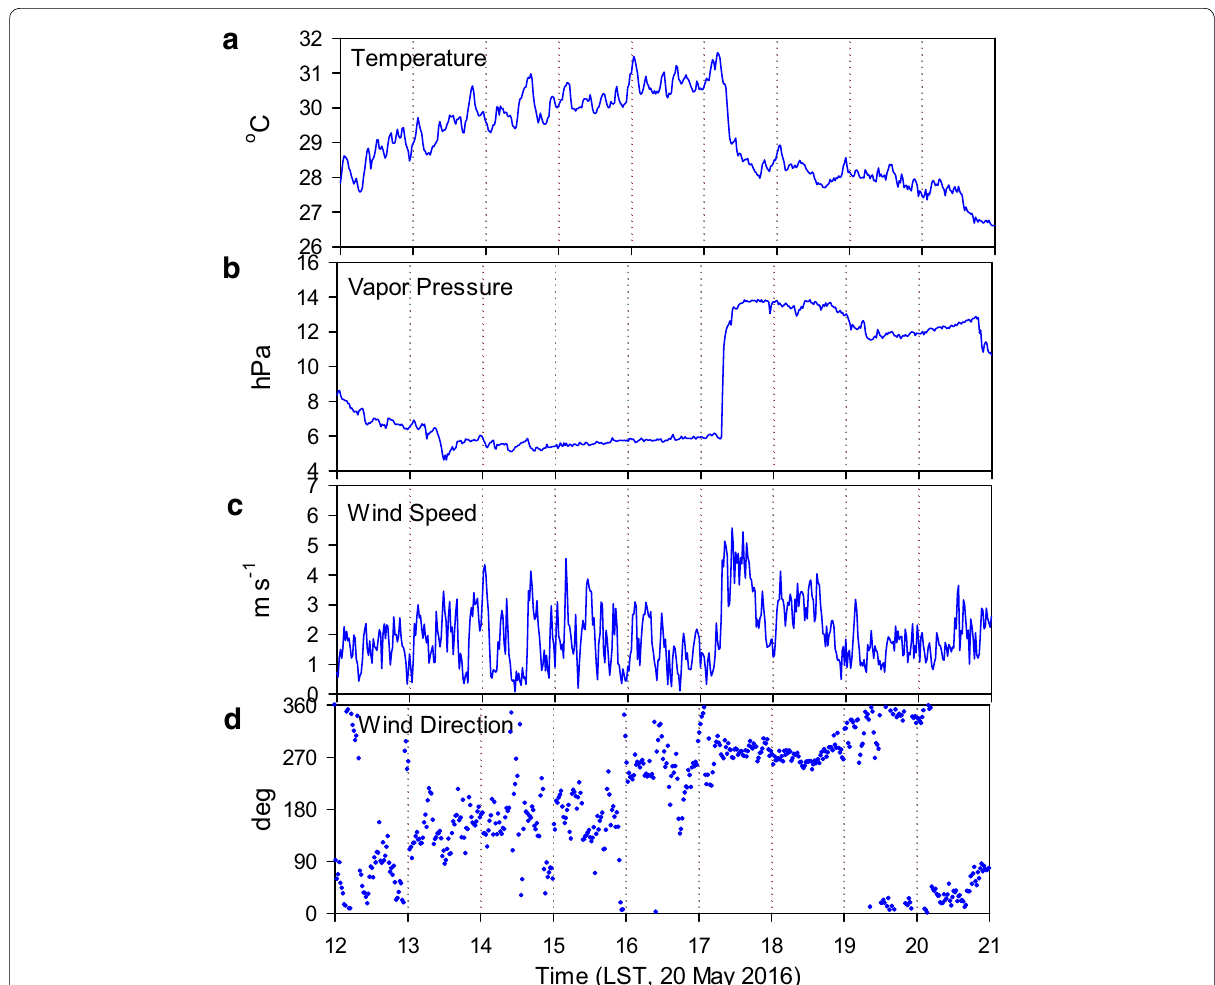
Fig. 5 Time series of a air temperature, b vapor pressure, c wind speed, and d wind direction at the Jungnang Station between 1200 and 2100 LST on 20 May